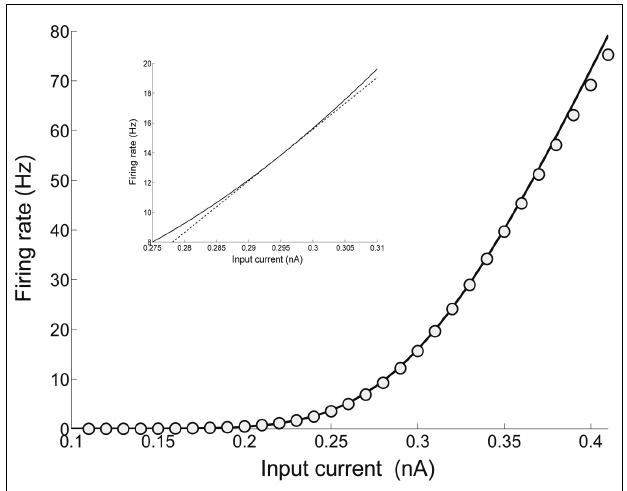
FIGURE 3 | Input–output function of an interneuron: the line is plot of the first-passage time formula of a LIF model with σ = 4.2 (Eq. 14), while the circles correspond to the fit of Eq. 15. In the inset, a close up is drawn (solid line) and the linear approximation using Eq. 30 (dashed line).